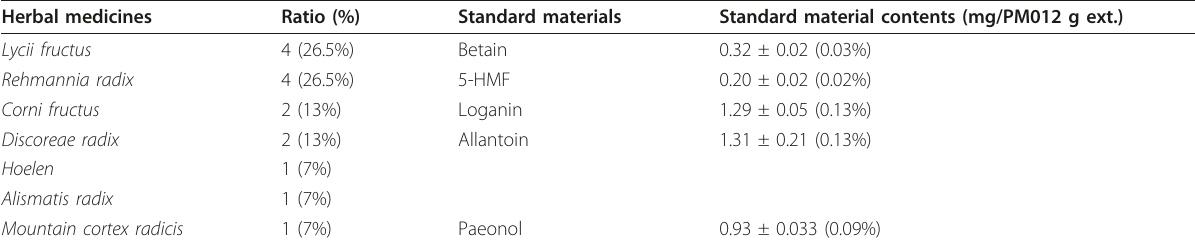
Table 1 The contents of PM012 and the amounts of standard materials Herbal medicines Ratio (%) Standard materials Standard material contents (mg/PM012 g